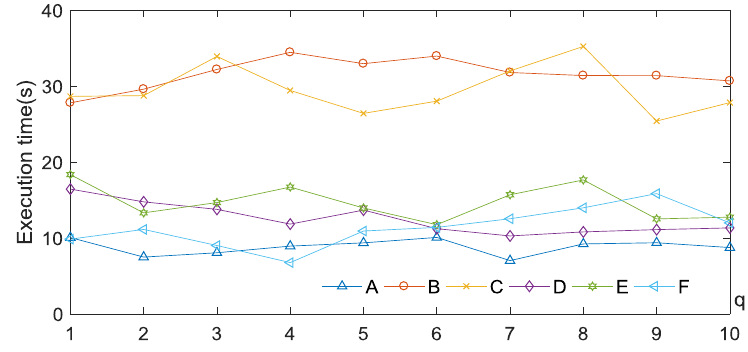
Figure 11. Average execution time of proposed method with different q in different images.